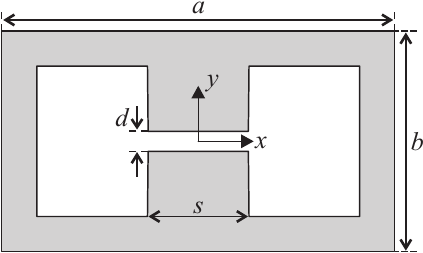
Figure 2. Cross-sectional view of the DRW.